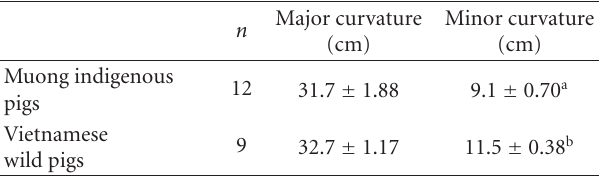
Figure 3: Comparative correlation of major curvature to stomach mass. Table 1: Comparative major and minor curvature of stomach (Mean ± SE).